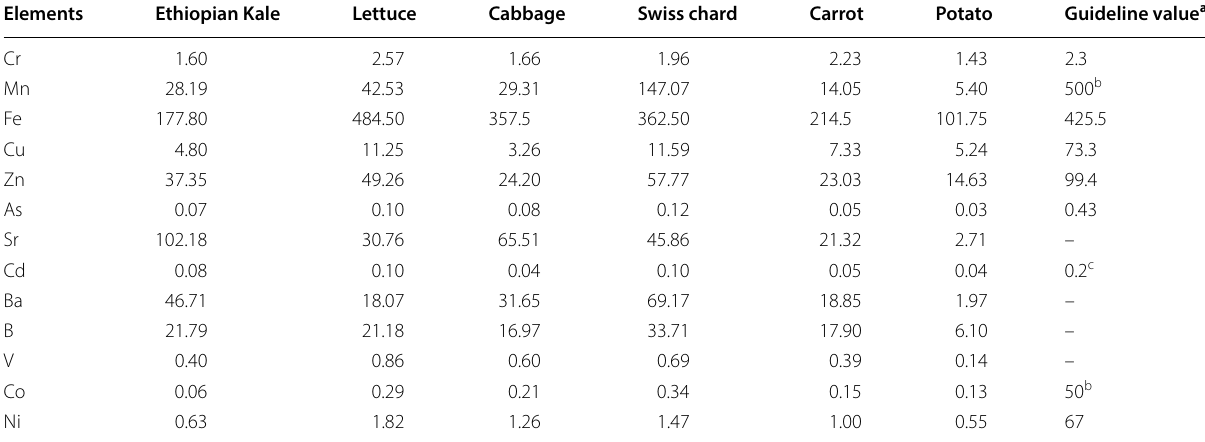
a Weigert (1991), b Pendias and Pendias (1992); c FAO/WHO (2001)